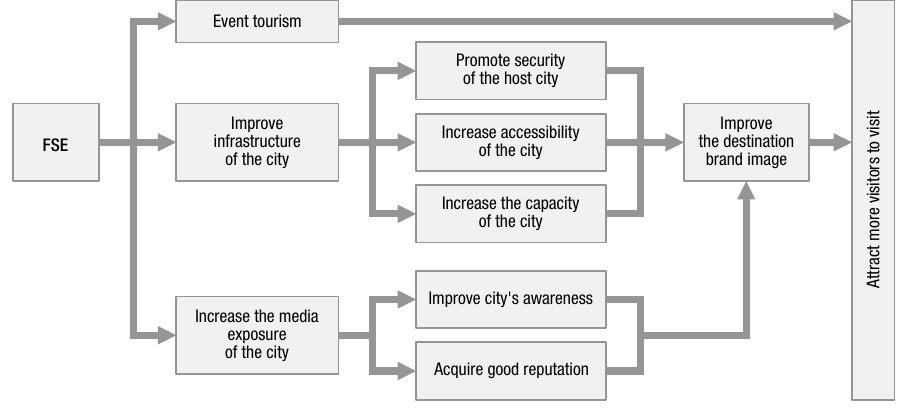
Fig. 1. The tourism effects of events on the host